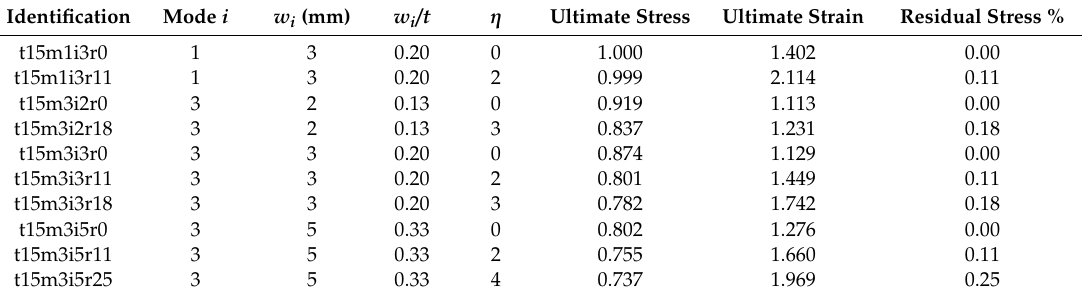
Figure 8. Load shortening curves for intermediate plates ( β = 1.352) with different initial imperfections in fundamental and critical mode and residual stresses. Table 2. Summary of data and main results for plates with a = 1.5 m, b = 0.6 m and t = 15 mm.